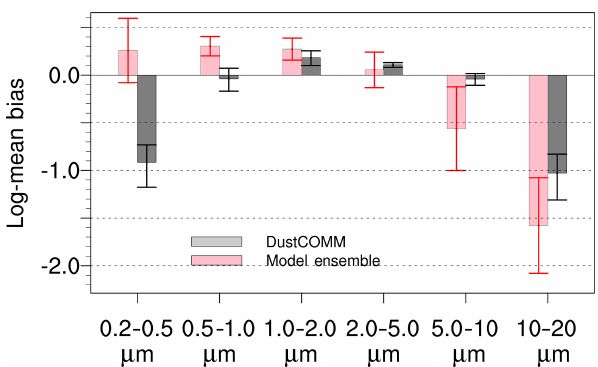
Figure 4. Average log-mean bias between measurements and Dust- COMM (grey) or model ensemble (pink) estimates of dust size dis- tributions (shown in Figs. 2 and 3) for different particle bins. The vertical bars represent the 95% confidence